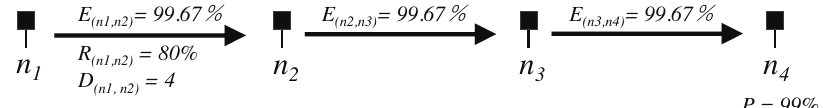
Figure 2. Example of Adaptive Packet Duplication (APD): If the required packet delivery ratio is P = 99%, distance is 3-carries, and the packet delivery ratio from n 1 to n 2 is 80%, n 1 creates four duplicated copies of a packet to suffice the delivery ratio P .